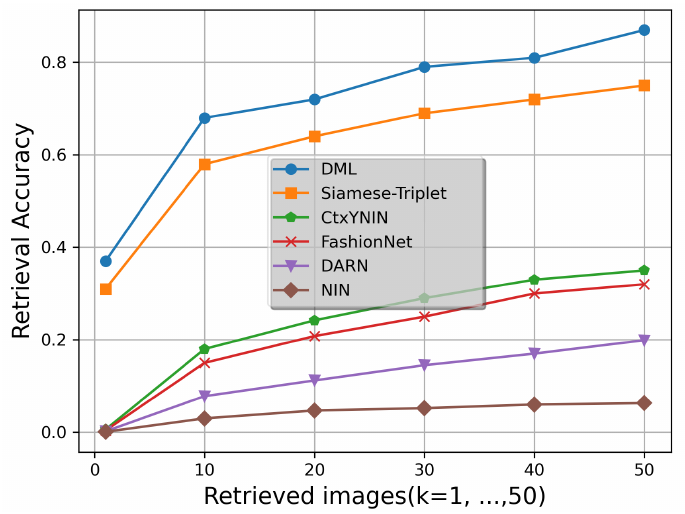
Figure 6. Top-k accuracy rates for different methods under comparison on DARN Consumer-to-shop retrieval dataset. The last four methods are reported by [6] and Siamese-Triplet is reported by